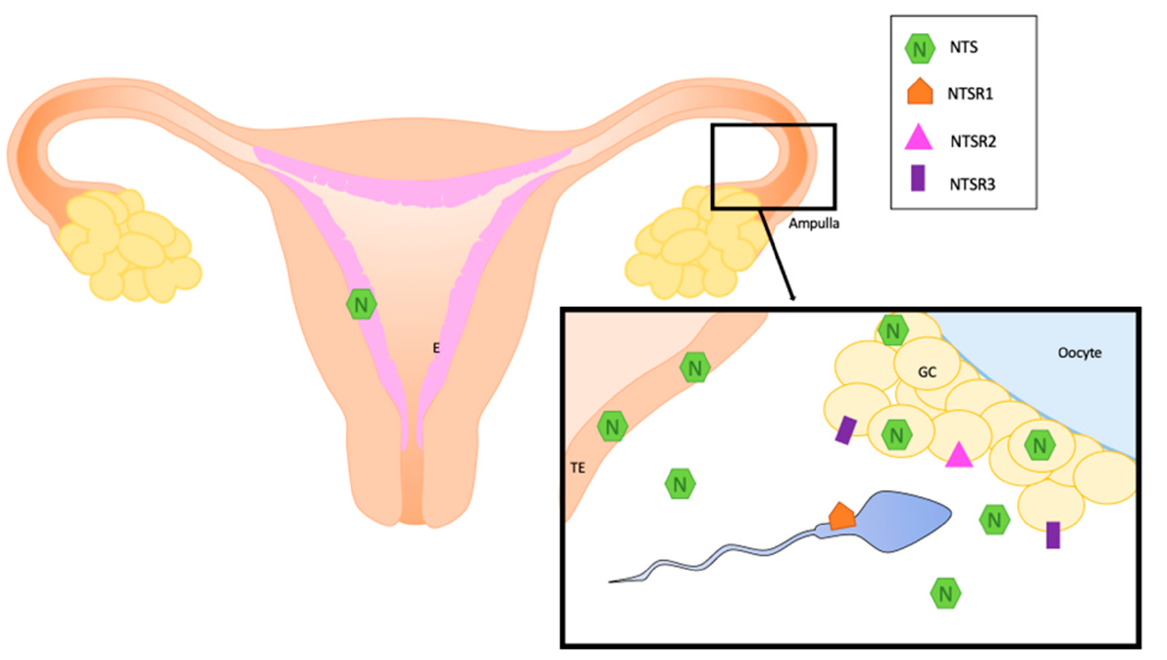
Figure 1. Localization of NTS and its receptors in normal human reproductive system. E: endome- trium, GC: granulosa cells, NTS: neurotensin, NTSR1; neurotensin receptor 1, NTSR2: neurotensin receptor 2, NTSR3: neurotensin receptor 3, TE: oviduct Table 1. Physiological expressions of NTS and its receptors in reproductive system in mammali- ans.